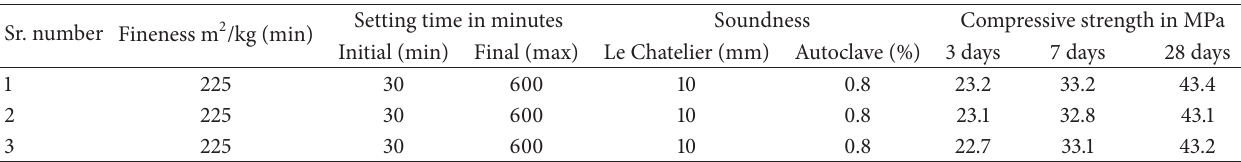
Table 3: Properties of cement.